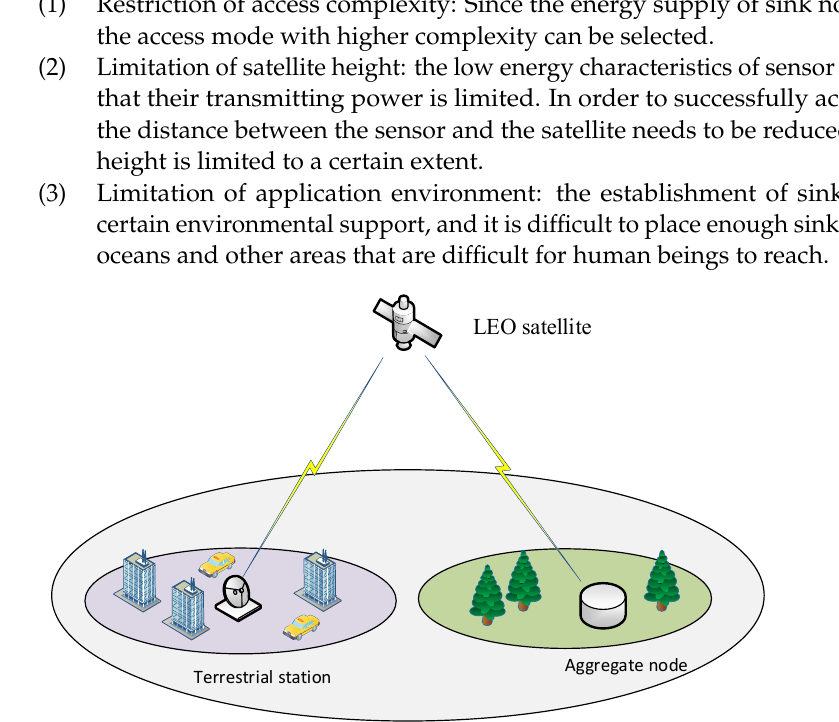
Figure 1. Satellite IoT scenario model with sink nodes.